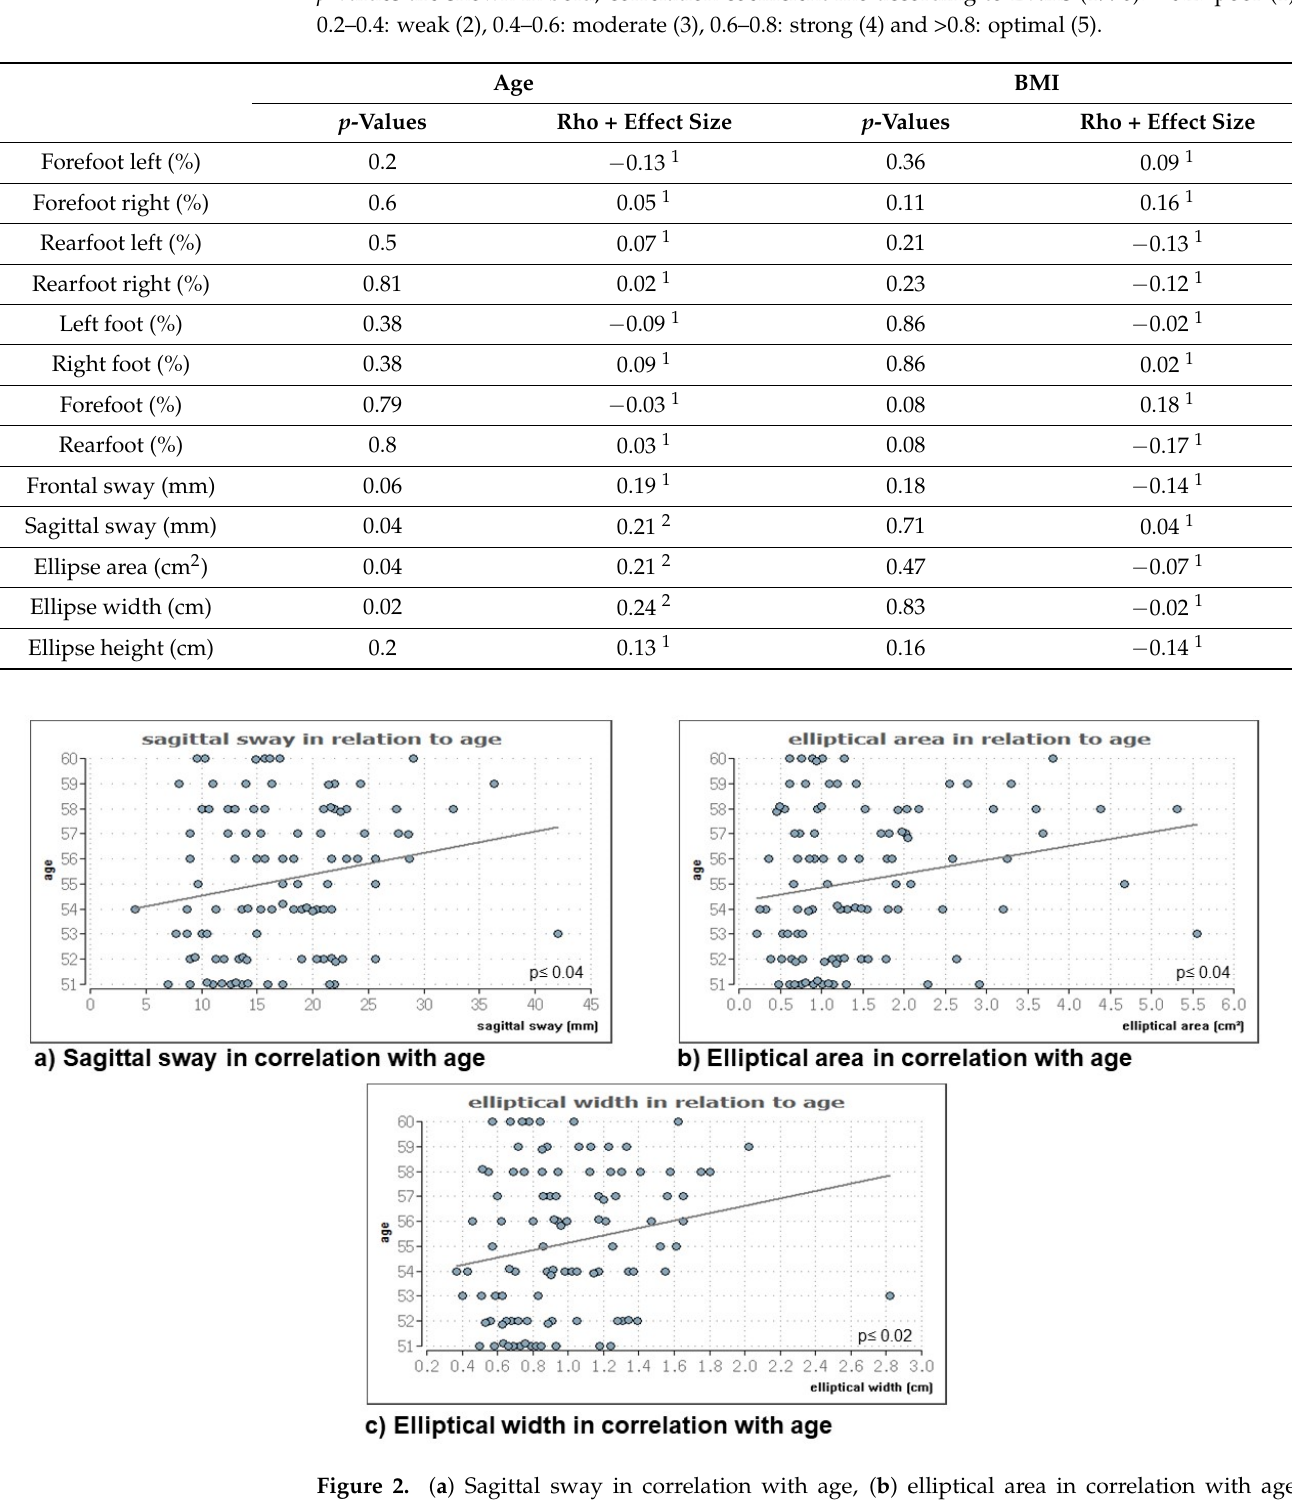
Table 2. Correlations of all parameters with demographic parameters (age and BMI). Significant p -values are shown in bold; correlation coefficient rho according to Evans (1996): <0.2: poor (1), 0.2–